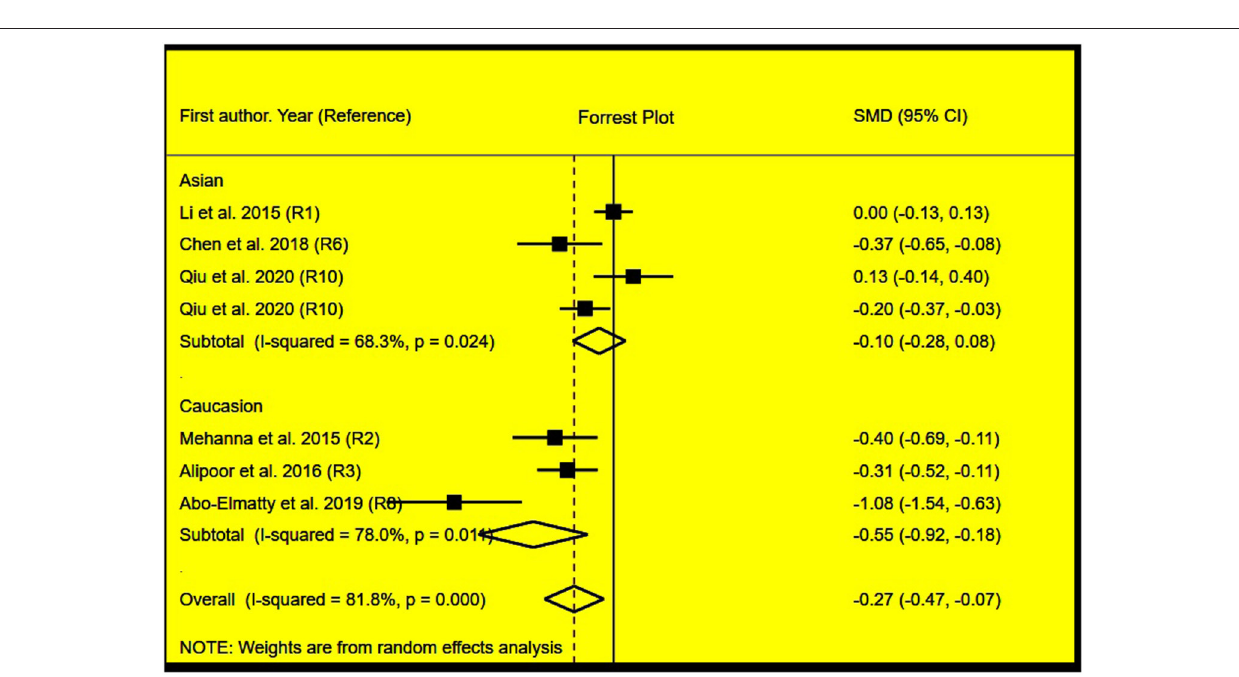
FIGURE 5 | Forest plot of the meta-analysis between miRNA-146a rs2910164 polymorphism and plasma HDL-C levels.